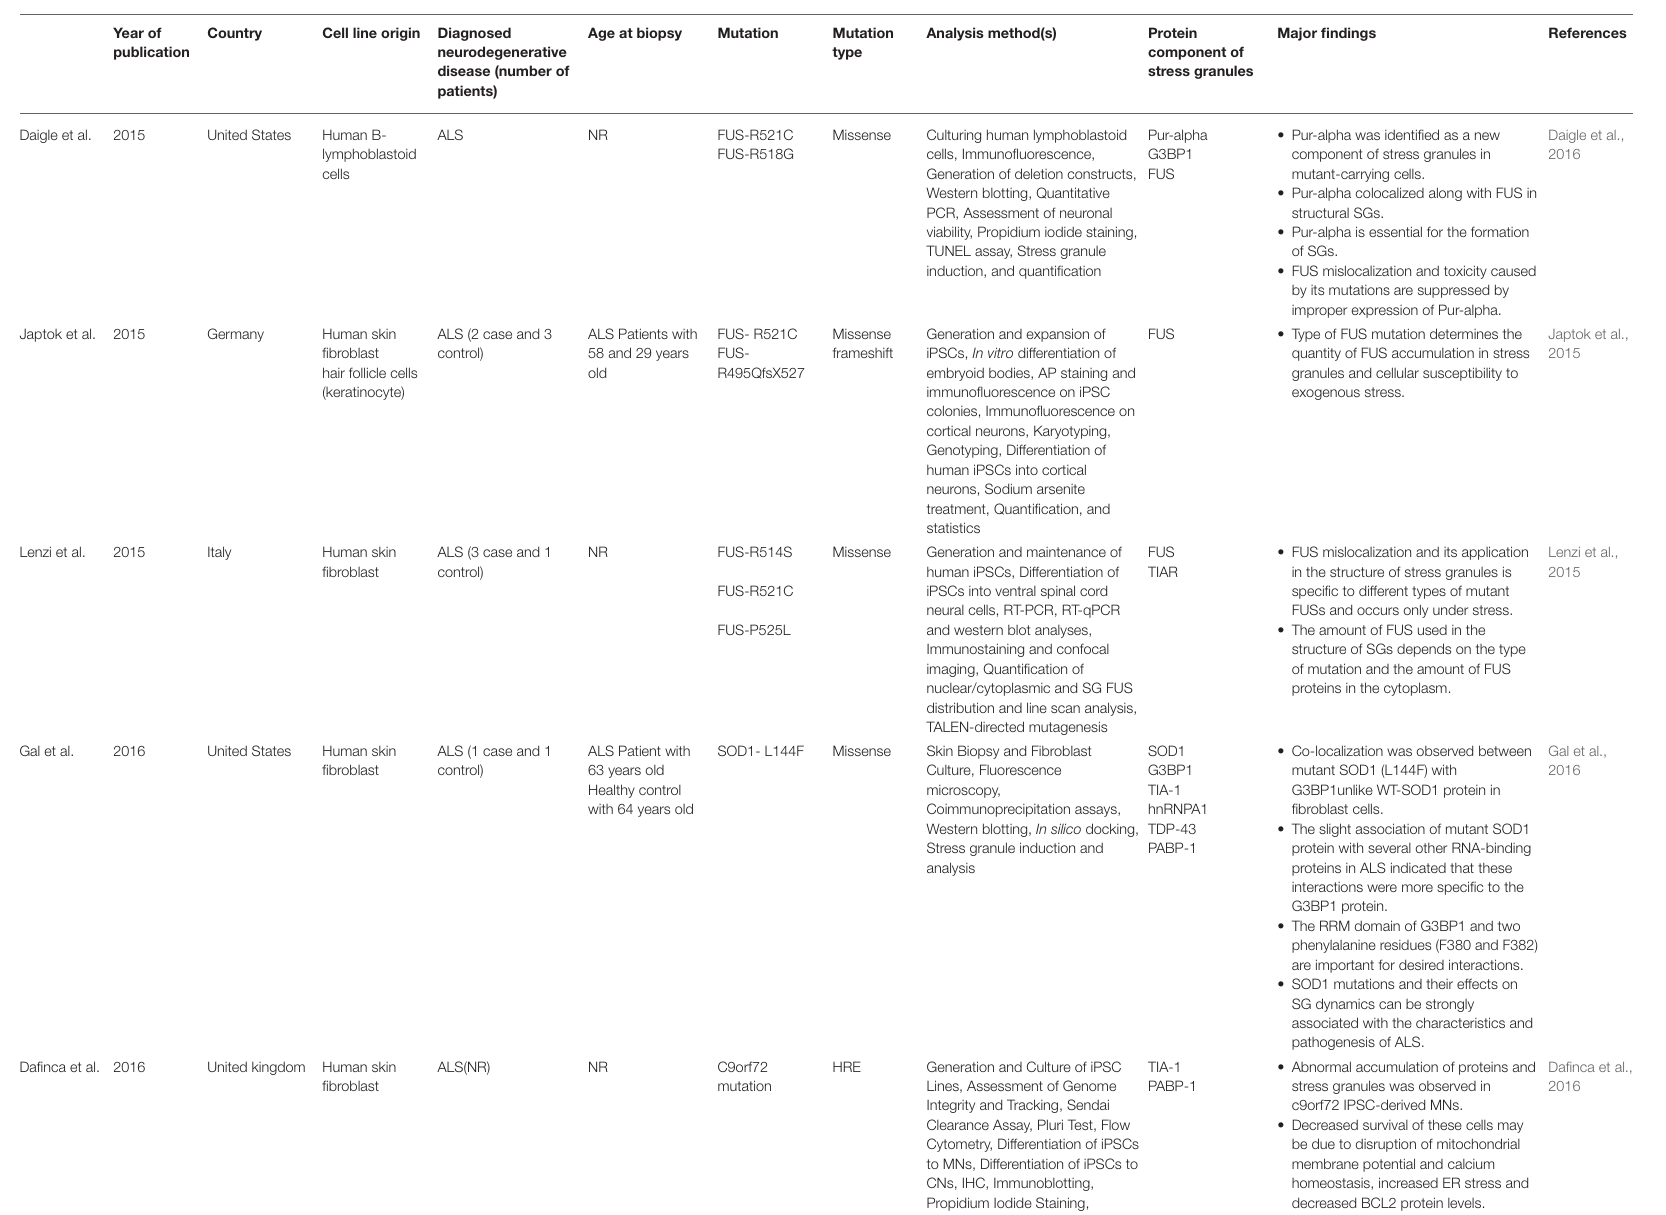
TABLE 3 | Stress Granules and ALS in human derived cell lines.